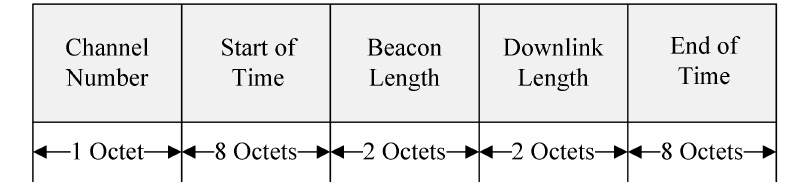
Figure 7. The format of the proposed Resource Info field.